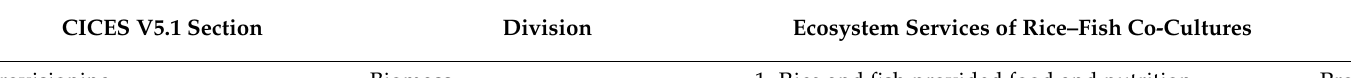
Table 2. Ecosystem services and goods and benefits valued from rice–fish co-cultures (following CICES V5.1; Liu et al. [21]; Liu et al.